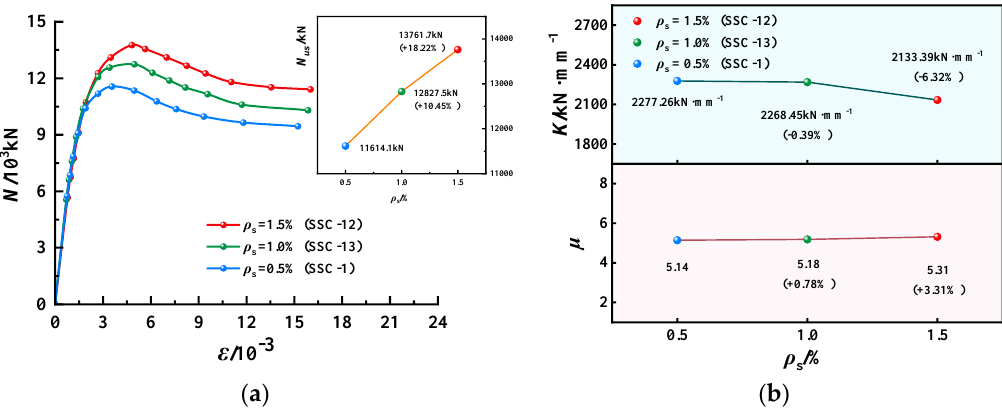
Figure 15. N - ε curves, K and µ of EGCSSCs with different ρ s : ( a ) N - ε curves of specimens with cross-section height of 800 mm. ( b ) K and µ of specimens with cross-section height of 800 mm.